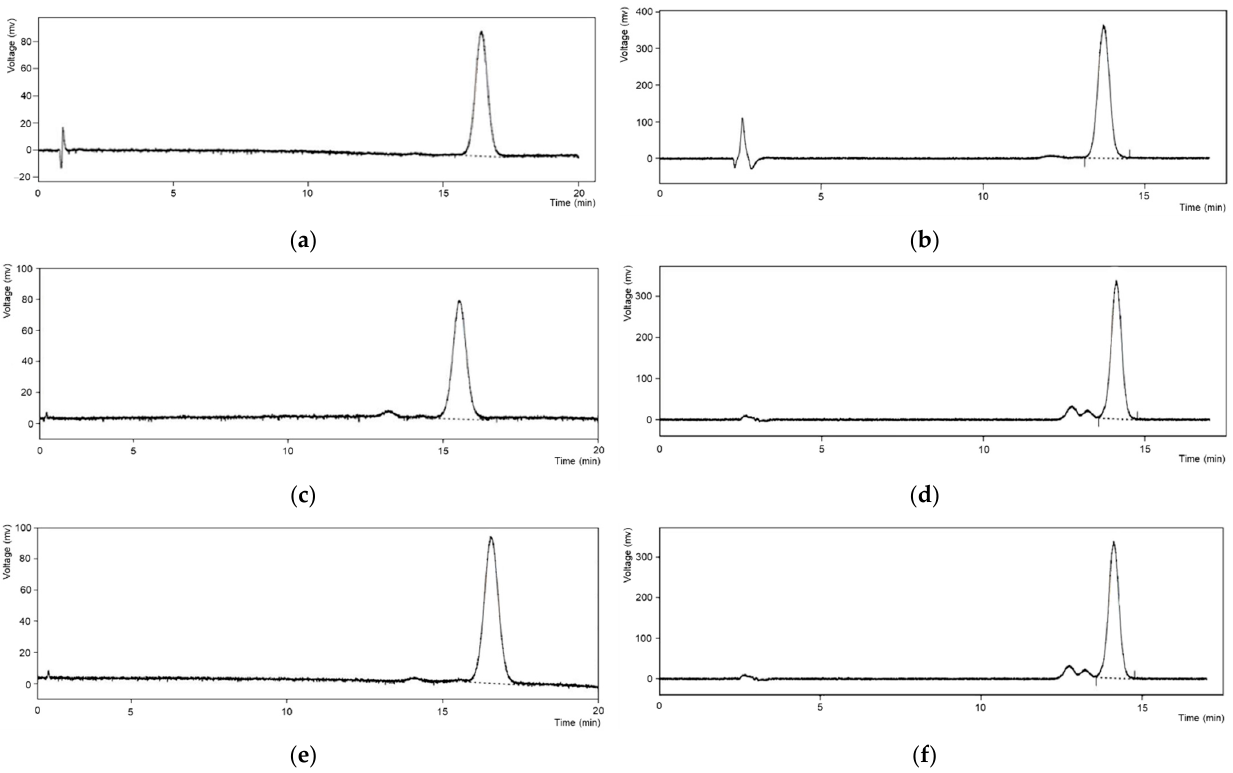
Figure 2. Chromatograms of retinoic acid in Cleoderm™. ( a ) Initial standard; ( b ) Standard at 60 days; ( c ) initial 0.025%; ( d ) 0.025% at 60 days; ( e ) initial 0.01%; ( f ) 0.01% at 60 days.